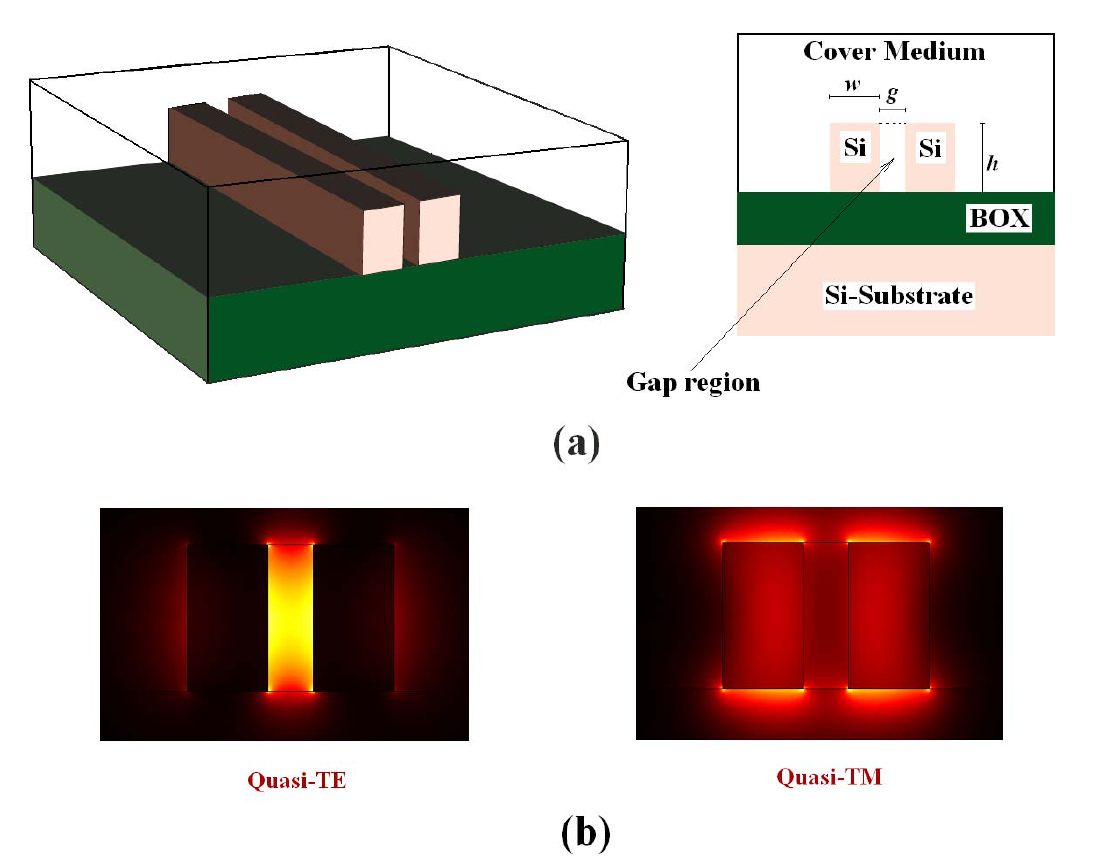
Figure 1 . (a) Slot waveguide typical structure (BOX: Buried Silicon Oxide). (b) Profiles of quasi-TE and quasi-TM modes confined in a slot